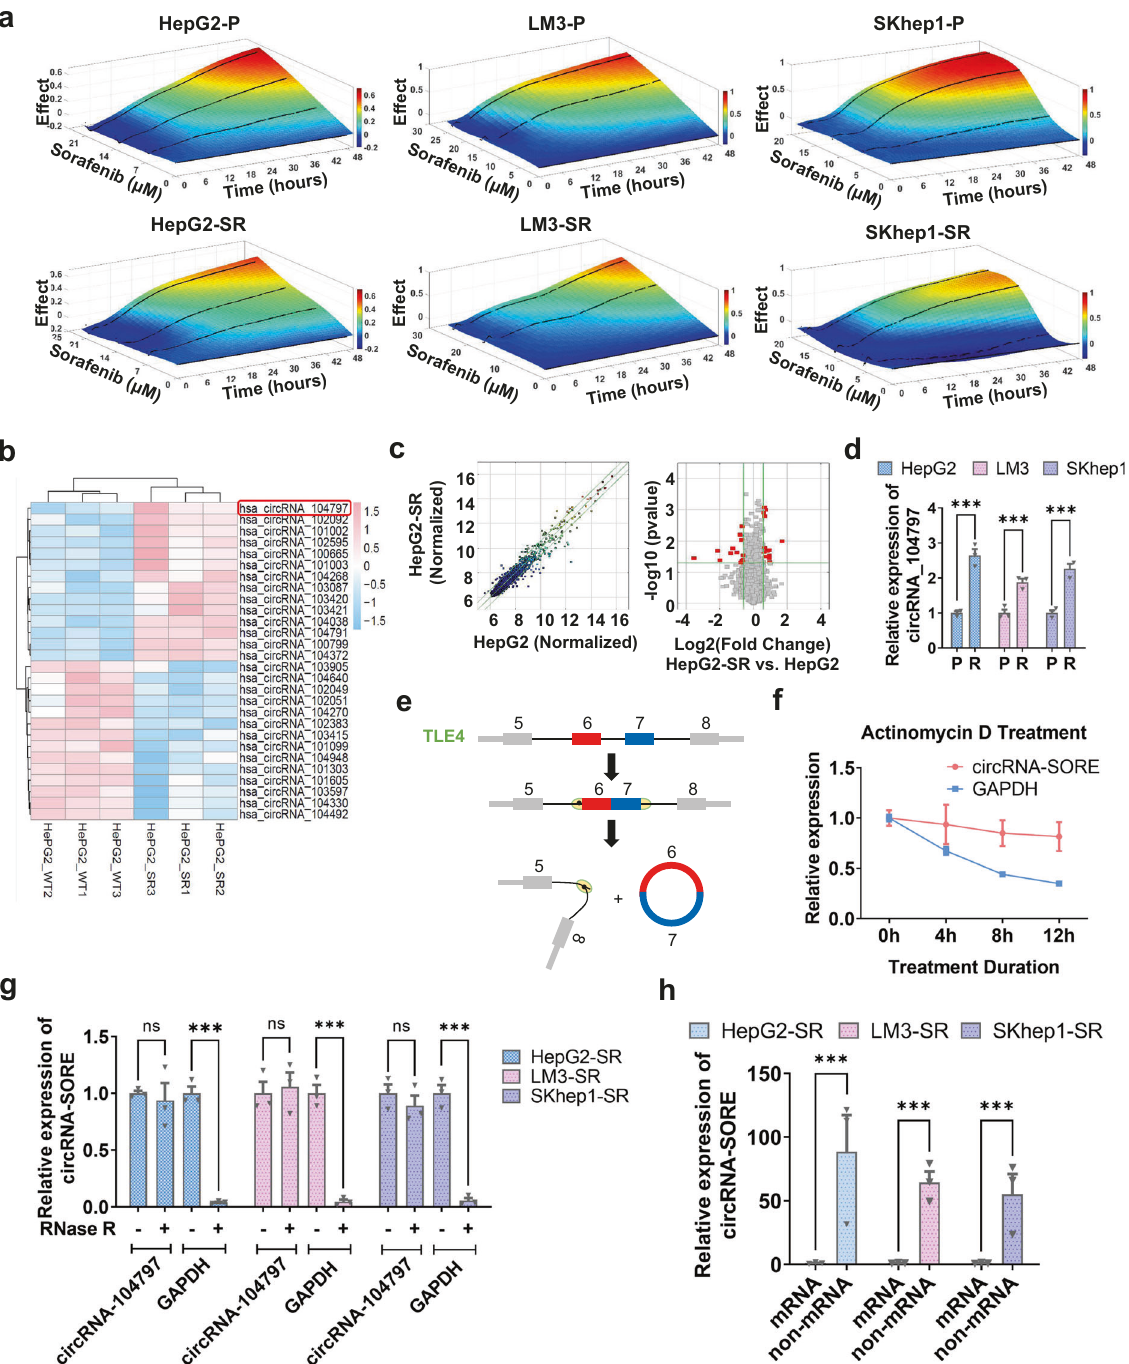
Fig. 1 CircRNA-SORE is overexpressed in sorafenib-resistant HCC cells. a Three sorafenib-resistant HCC cell lines (HepG2-SR, LM3-SR, and SKhep1-SR) were established and con fi rmed by the Real-time Cell Analysis xCELLigence System (Roche Applied Sciences). Curves demonstrate the inhibitory effect of sorafenib on parental (P) and sorafenib-resistant (SR) cell lines. b Hierarchical clustering of 14 upregulated circRNAs and 14 downregulated circRNAs in HepG2-SR cells compared with parental HepG2 cells by Arraystar Human CircRNA Array analysis. CircRNAs with fold change >2 and p < 0.05 were selected as signi fi cantly different. c Scatter plots (left panel) and volcano plots (right panel) of the differentially expressed circRNAs. Red dots indicate differentially expressed circRNAs ( p < 0.05 and fold change > 2). d CircRNA_104797 levels (normalized by GAPDH) in parental (P) and resistant (R) cell lines treated with the indicated concentrations of sorafenib (7 μ M for HepG2, 6 μ M for LM3 and SKhep1) for 72 h. e Diagram illustrating back-splicing of circRNA-SORE from the TLE4 host gene. f Time-course of the relative expression of circRNA-SORE and TLE4 in HepG2-SR cells treated with actinomycin D (10 µg/mL). g qPCR analysis of circRNA-SORE and GAPDH mRNA in HepG2-SR, LM3-SR and SKhep1-SR cells with or without RNase R treatment for 30 min at 37 °C. h Relative expression of circRNA-SORE in mRNA and non-mRNA samples in the indicated cell lines. Three independent experiments with three technical repetitions were performed. Data are expressed as mean ± SEM (error bars). Statistical analyses used Student ’ s t test. *** p < 0.001. NS not signi fi